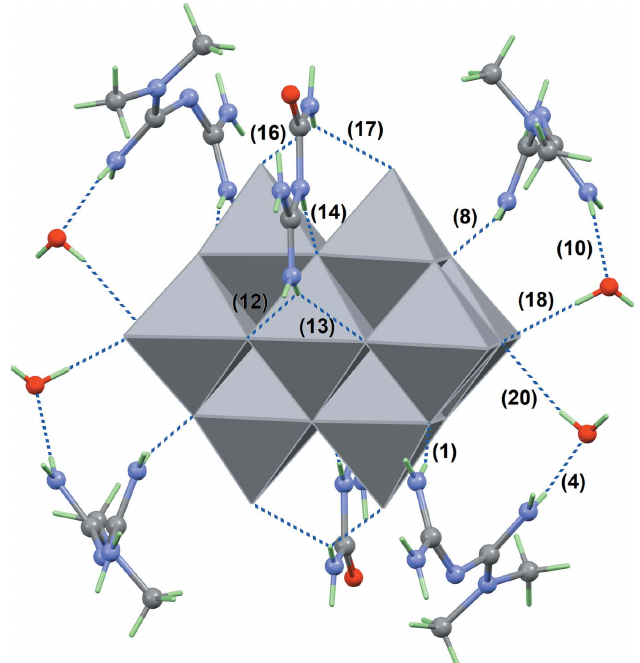
Figure 2 Main interactions between the decavanadate(V) anion (polyhedral representation) and the first shell including six cations and four water molecules (ball-and-stick representation). Hydrogen bonds are repre- sented by blue dashed lines, and the label associated to each hydrogen bond refers to its entry in Table 1.